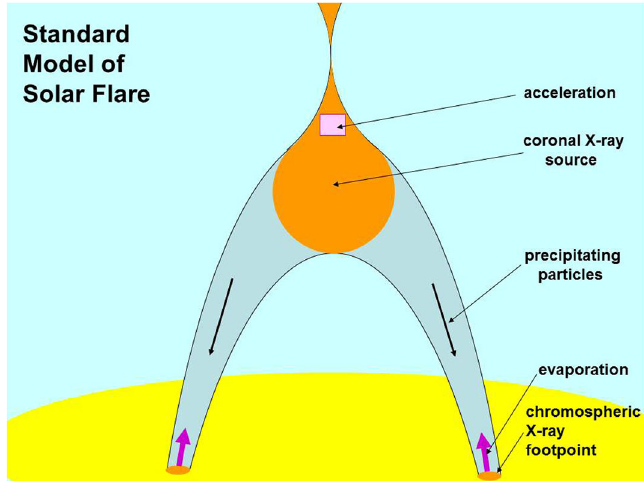
Fig. 13 A schematic drawing of the standard flare scenario assuming energy release at high